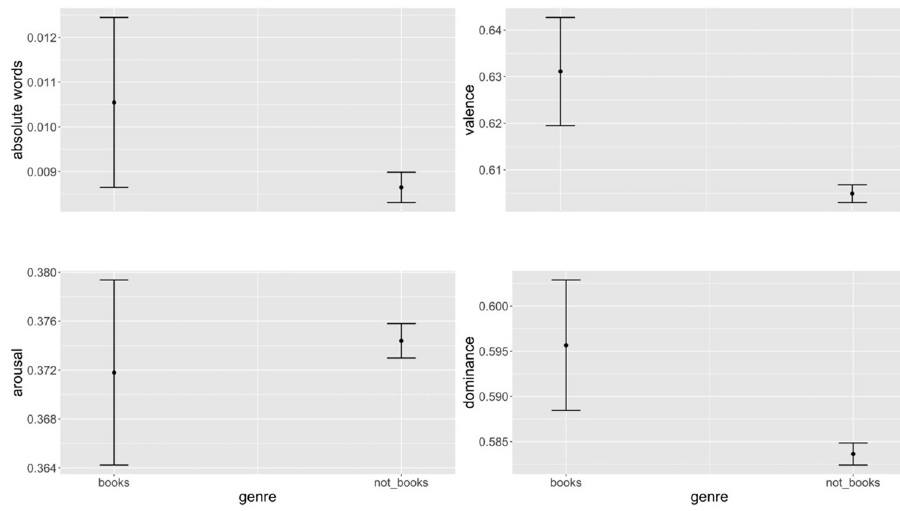
Fig 5. Predicted marginal means for the effect of book-themed and non-book-themed discussion on valence, arousal, dominance, and absolute words.